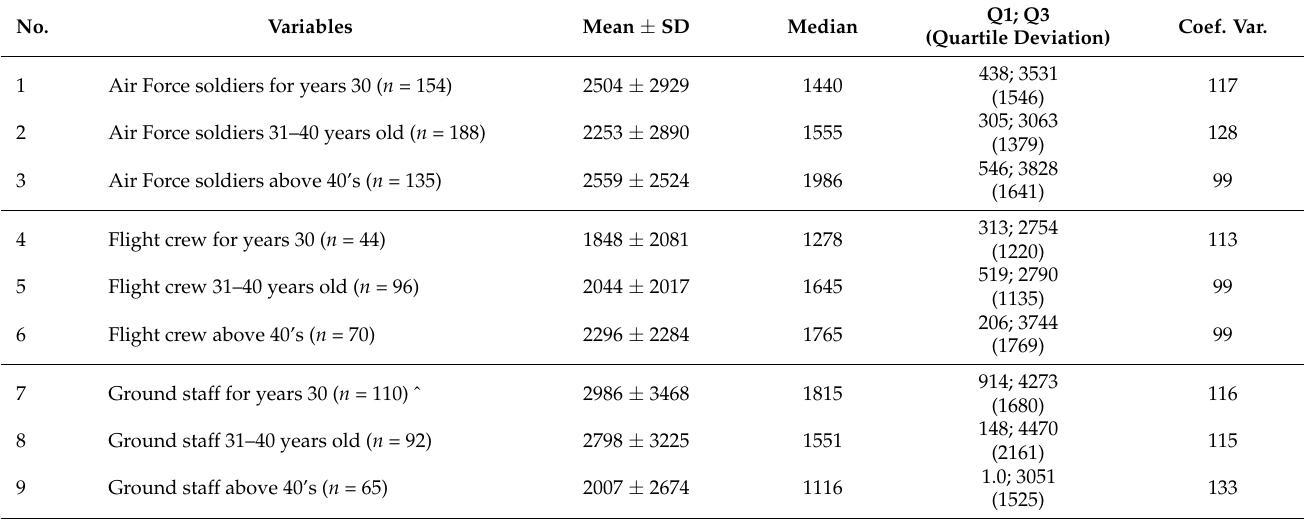
Table A5. Summary of total MET related to leisure